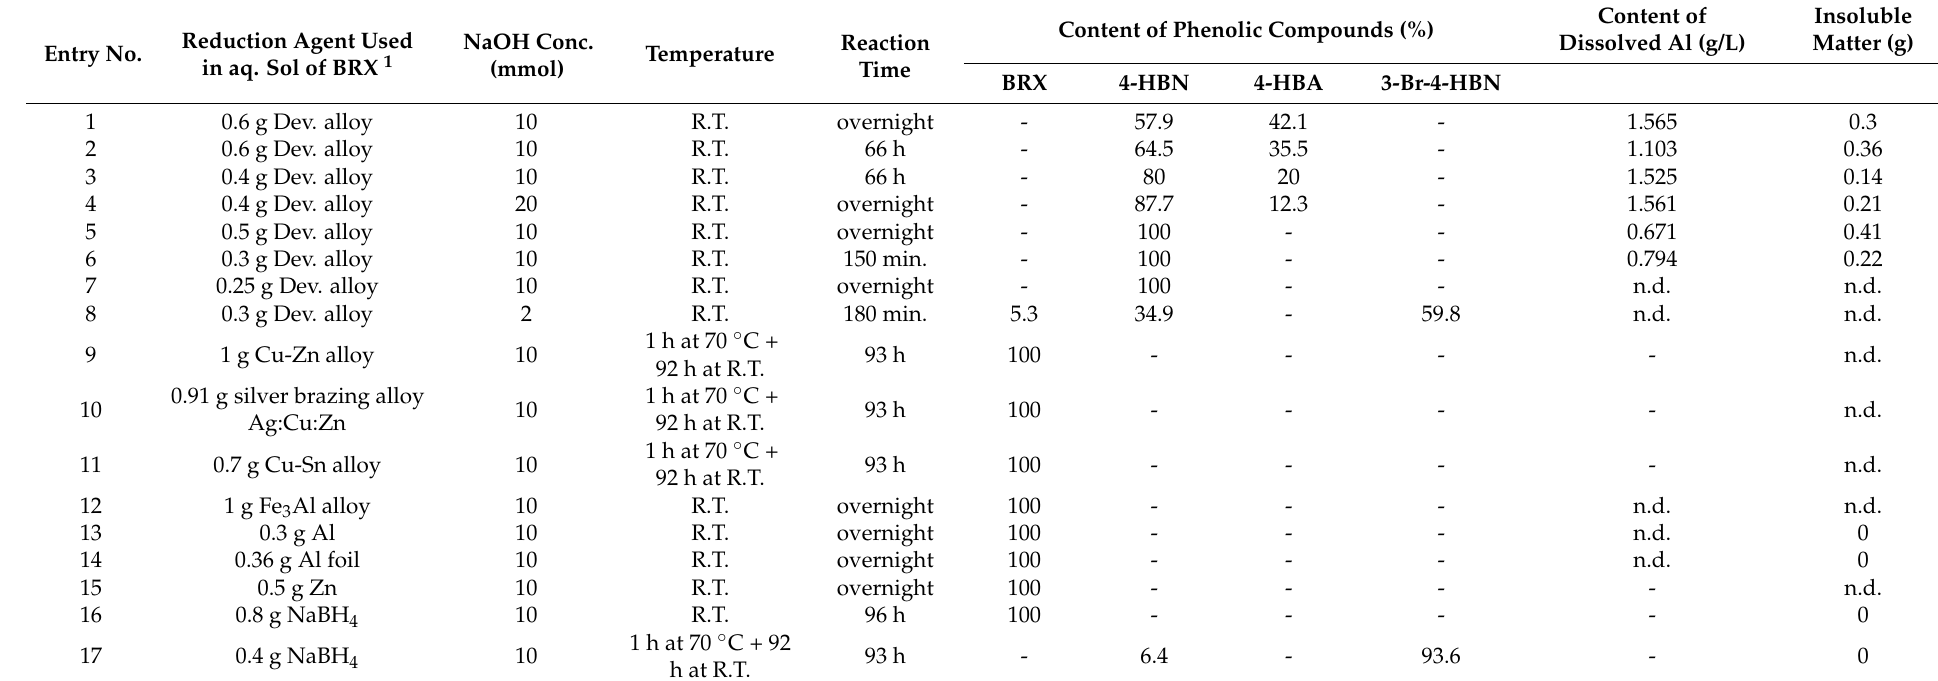
Table 1. Efficiencies of different electropositive metals, their alloys and NaBH 4 on the HDB of